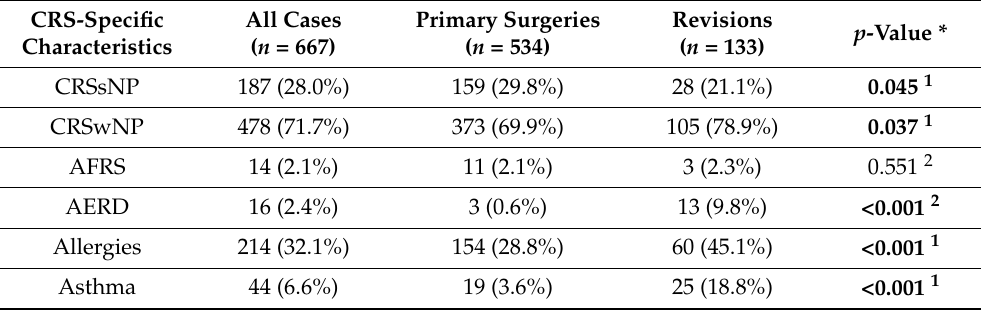
Table 2. Chronic rhinosinusitis (CRS)-specific characteristics, such as CRS without nasal polyps (CRSsNP), CRS with nasal polys (CRSwNP), allergic fungal rhinosinusitis (AFRS) and aspirin- exacerbated respiratory disease (AERD) as absolute numbers and